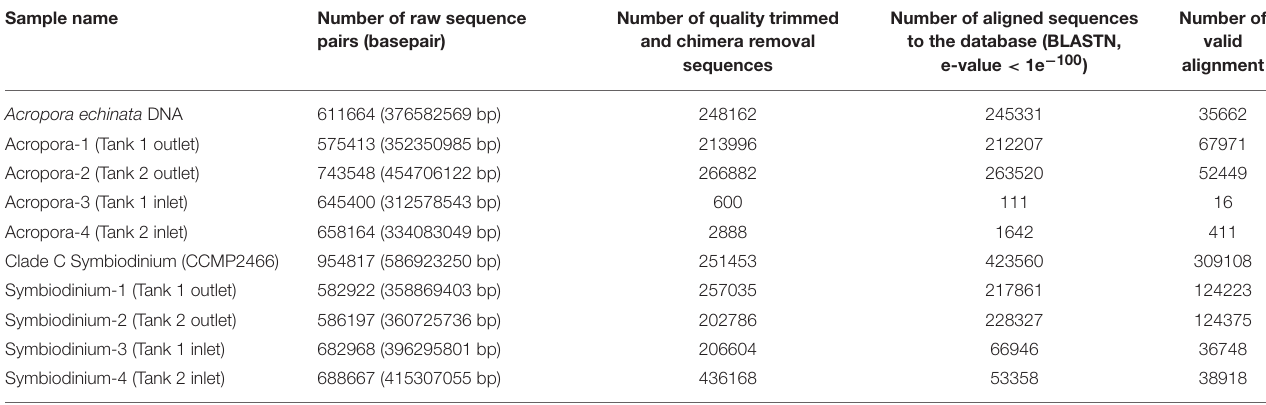
TABLE 2 | Summary of sequencing of PCR amplicons from eDNA in culturing tanks (Tank 1 and Tank 2) and positive controls for Acropora and Symbiodinium (isolated DNAs of Acropora echinata and cultured clade C Symbiodinium CCMP2466,